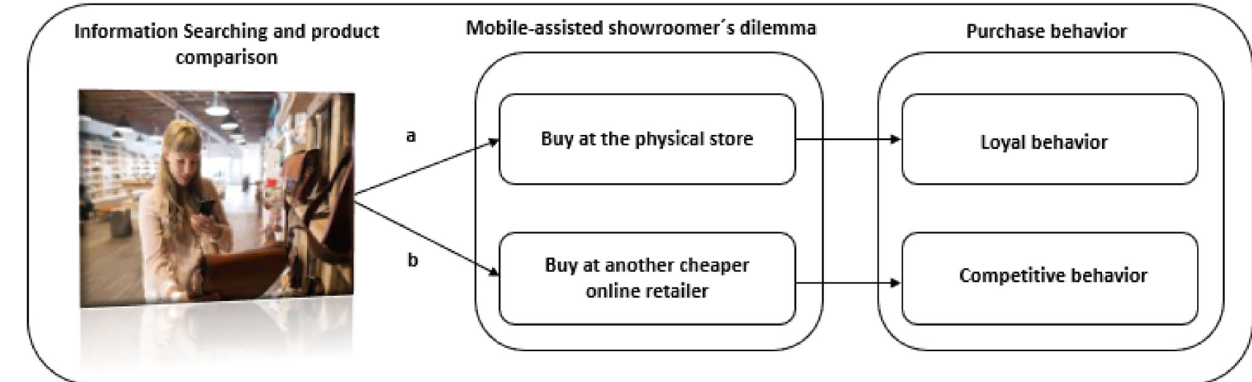
Fig. 1 Mobile-assisted-showroomer ’ s dilemma at brick-and-mortar